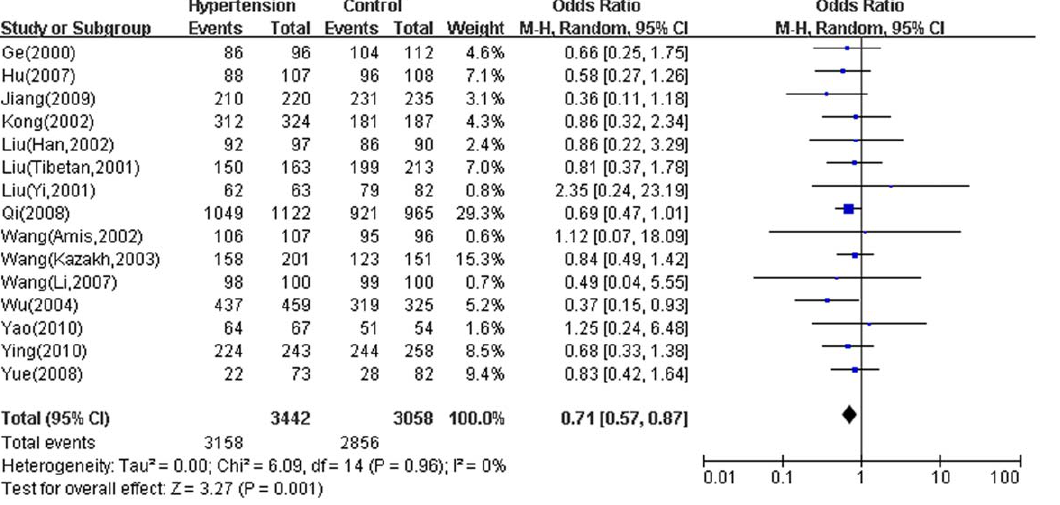
Table 3. The characteristics of all included studies for the A-6G polymorphism in the sex-specific subgroup analysis.